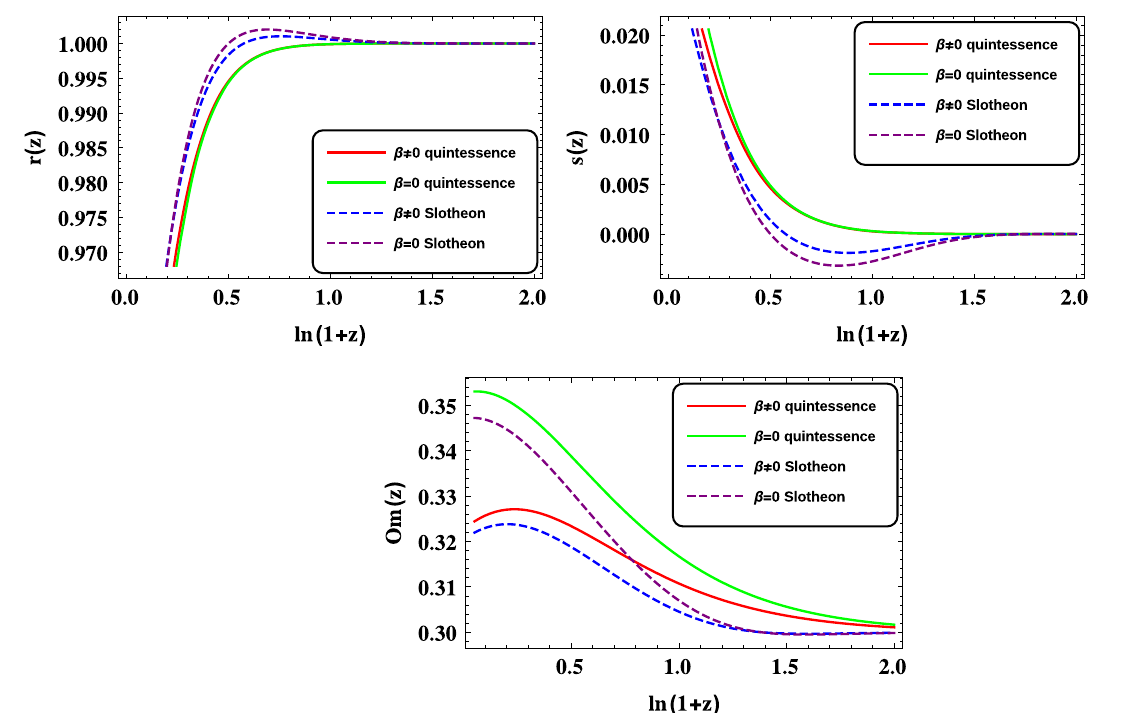
Fig. 7 Variations of r with z (top left), s with z (top right) and Om ( z ) with z (bottom) for four different cases, namely minimally coupled quintessence model ( β = 0, solid green line), coupled quintessence